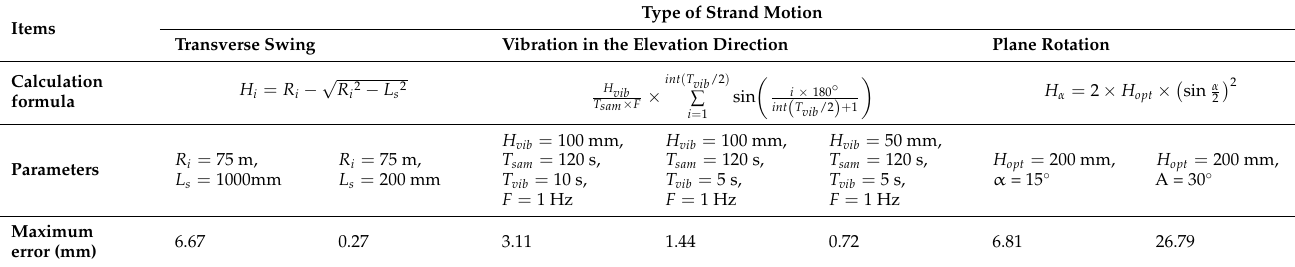
Table 2. Summary of measurement errors caused by different types of strand shaking.